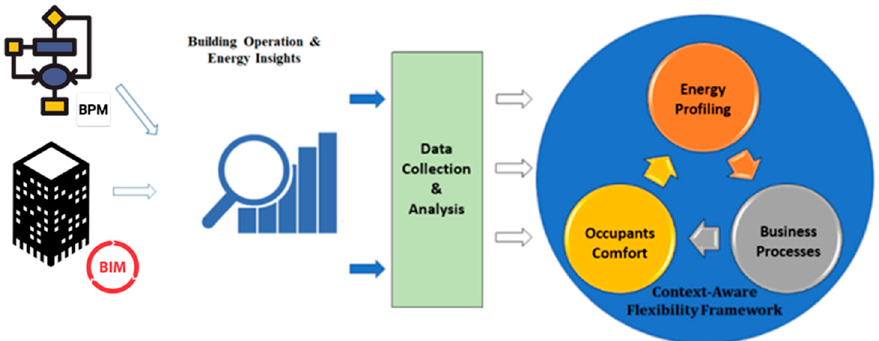
Figure 1. General energy management framework. BPM: business process management; BIM: building